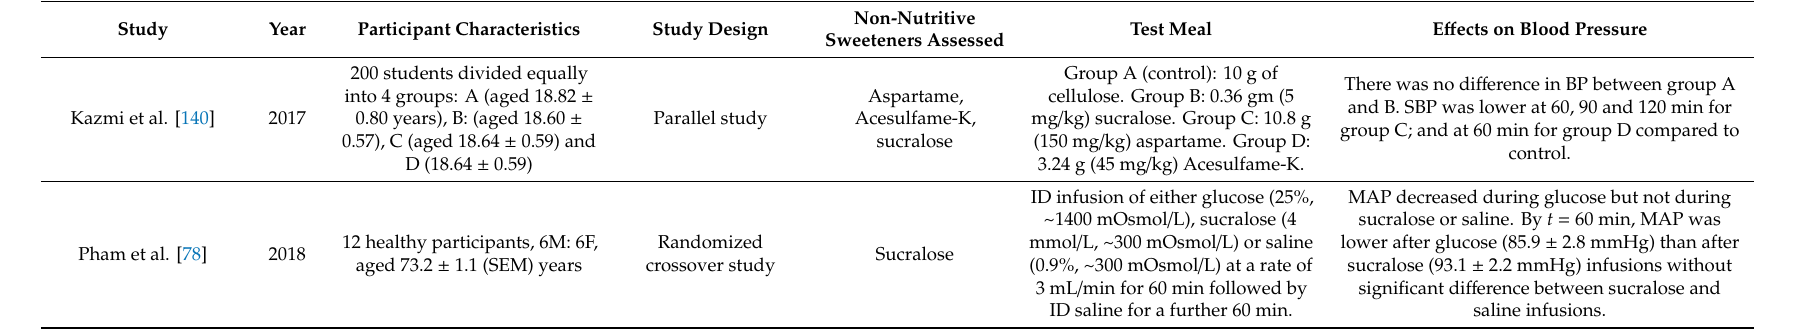
Table 3. Studies relating to the e ff ects of non-nutritive sweeteners on blood